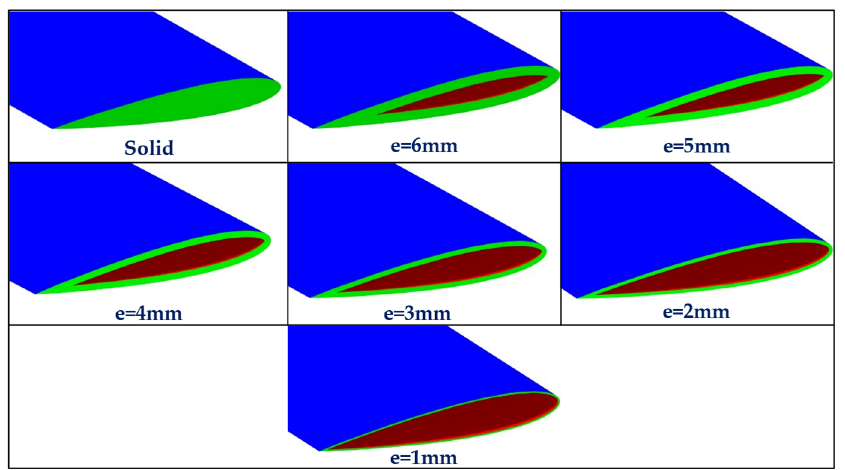
Figure 9. Cross-sections of the designed models of the rotor blade 1 with different thickness values.